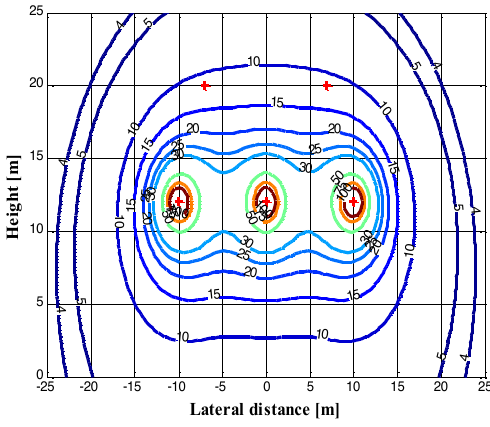
Figure 11: Contours lines of the magnetic induction strength around the phase conductors at mid-span length.